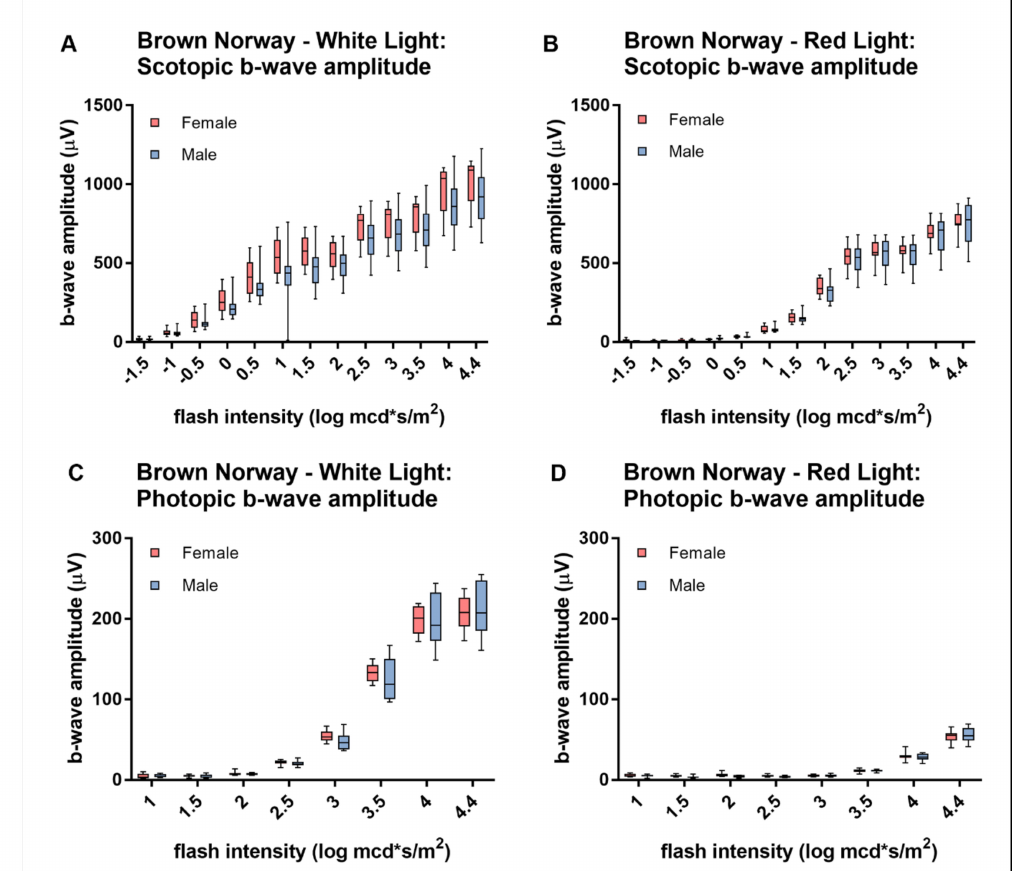
Figure 5. Sex di ff erences in white- and red-light ERG responses in Brown Norway rats. There is no significant di ff erence in the scotopic ( A , C ) and photopic ( B , D ) b-wave amplitudes between female and male Brown Norway rats, neither for white (A,B) nor for red light ( C,D ). Statistics: t-test corrected with Holm-Sidak method for multiple